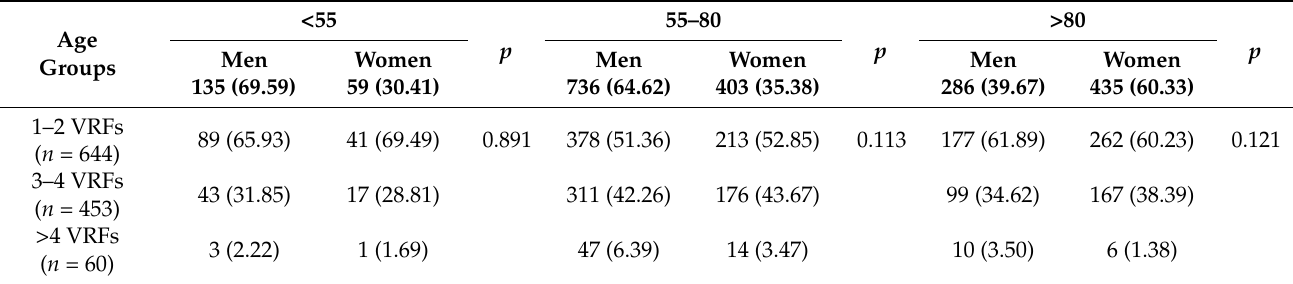
Table 4. Relationship of risk factors according to age groups, stratifying the sample by sex; men ( n = 1157) and women ( n =